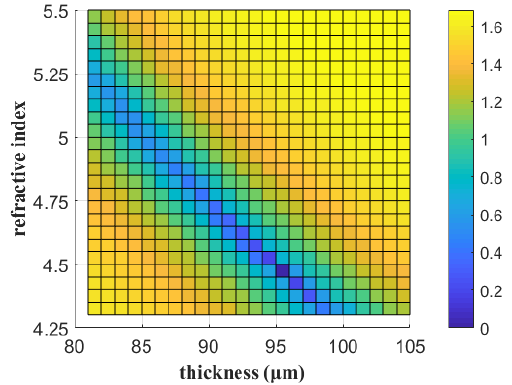
Figure 9. The distribution of the 𝛿 in Equation (6).